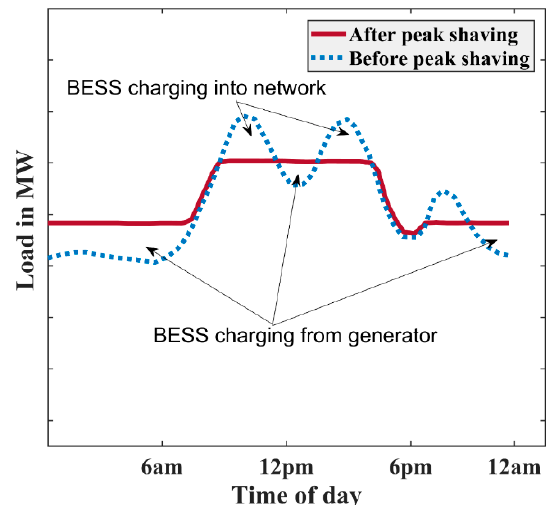
Figure 10. The peak load shaving technique using BESS. It is the mostly used energy storage system (ESS) for peak-shaving. By using BESS, the PQ of the grid can also be improved [79].